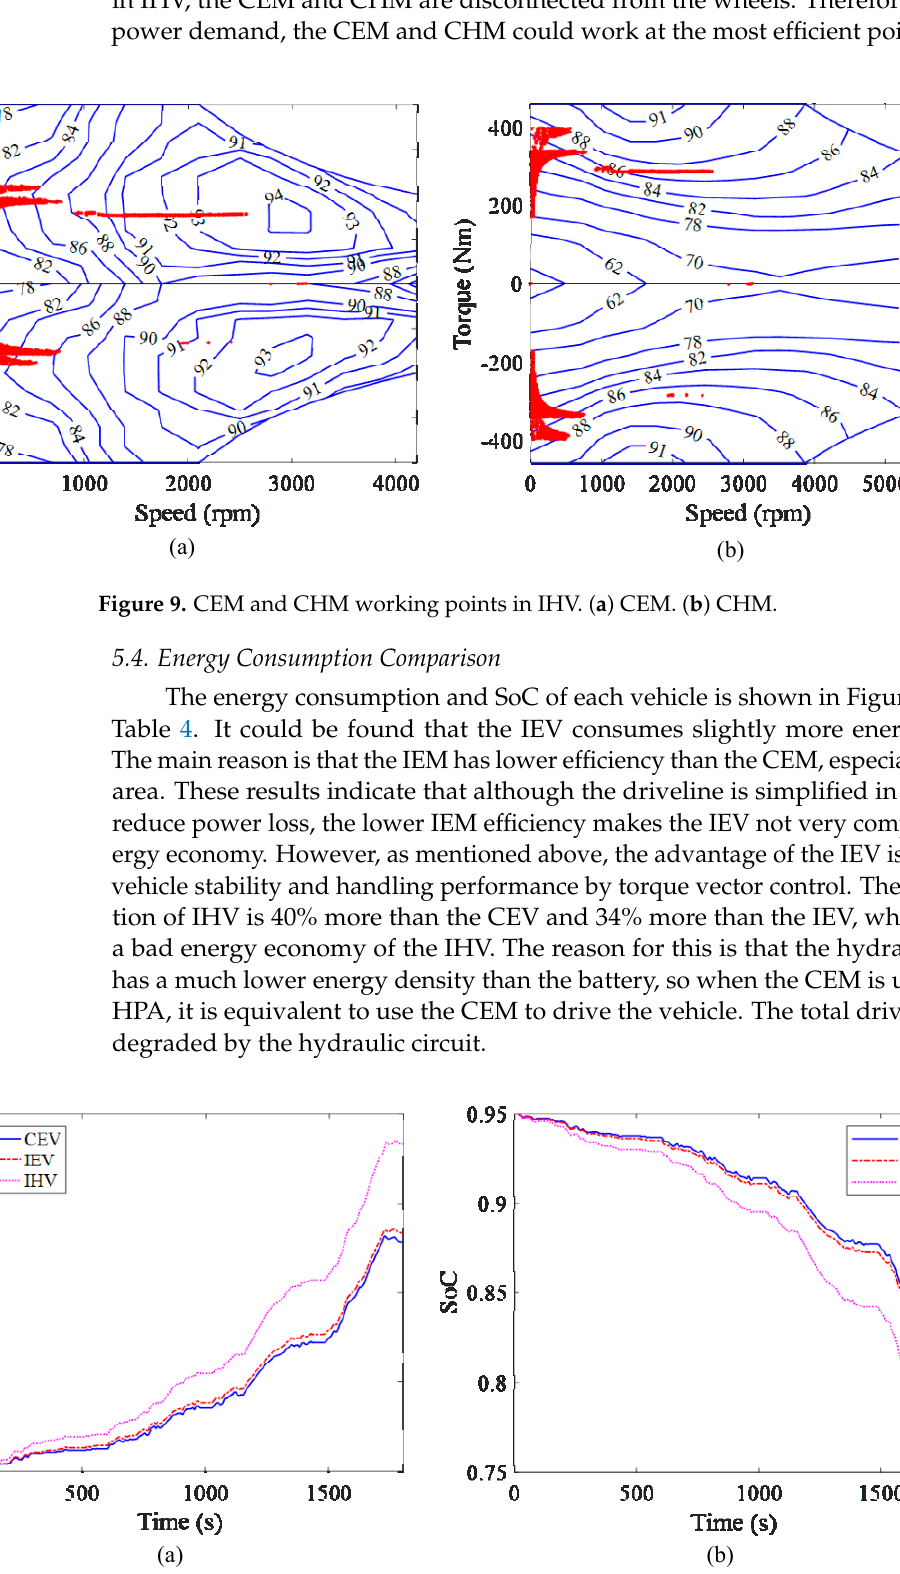
Figure 8. HPA gas pressure and volume change during WLTP-3.